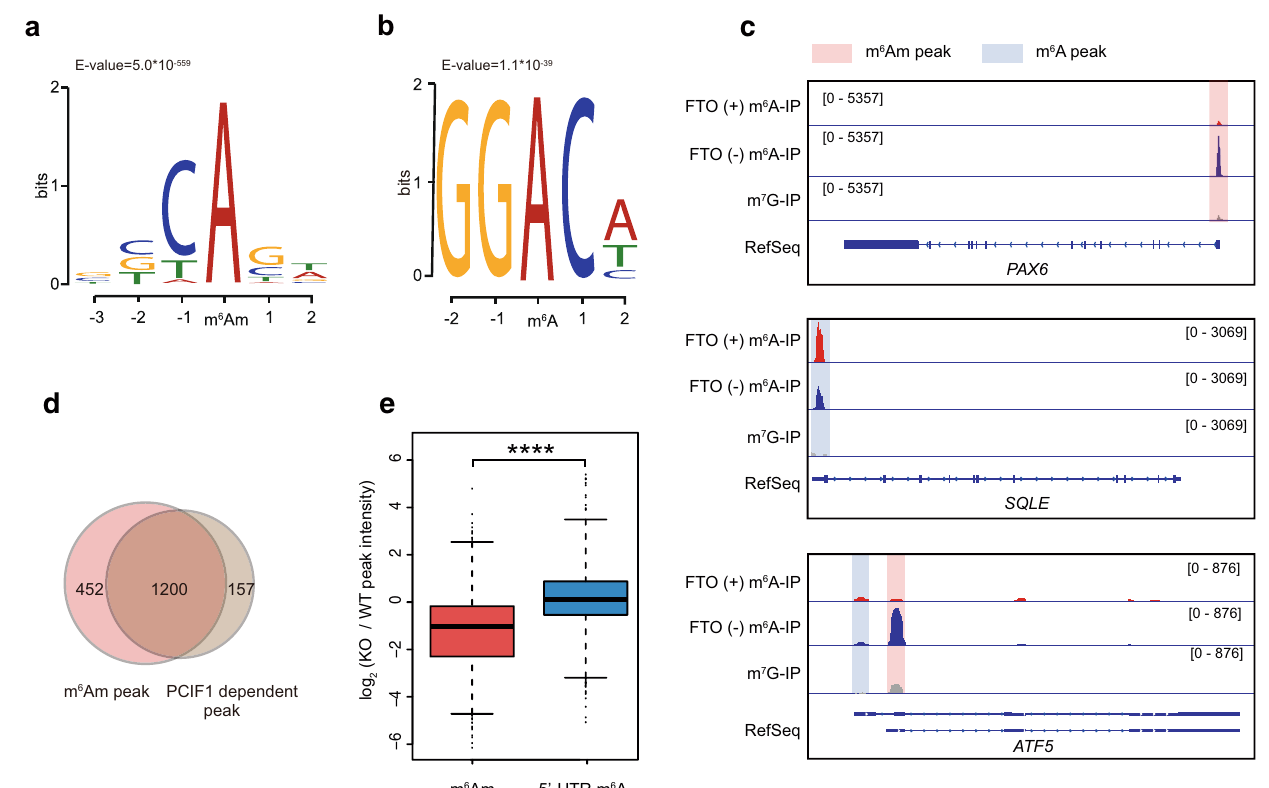
Fig. 2 m 6 Am-seq uncovers the high-con fi dence m 6 Am and 5 ′ -UTR m 6 A methylation in the human transcriptome. Motif analysis of m 6 Am peaks ( a ) and 5 ′ -UTR m 6 A peaks ( b ) identi fi ed by m 6 Am-seq. c Representative views of typical m 6 Am peaks and 5 ′ -UTR m 6 A peaks on mRNA. The methylation peak in the 5 ′ -UTR of PAX6 was lost in “ FTO ( + ) m 6 A-IP ” samples, suggesting a demethylase-sensitive m 6 Am modi fi cation (top); the methylation peak in the 5 ′ - UTR of SQLE retained well in “ FTO ( + ) m 6 A-IP ” samples, suggesting a demethylase-insensitive m 6 A modi fi cation (middle); while multiple isoforms of ATF5 were differentially marked by m 6 Am and 5 ′ -UTR m 6 A (bottom). Pink and blue background colors denote m 6 Am and m 6 A signals, respectively. d Venn diagram showing the overlap between m 6 Am peaks identi fi ed directly by m 6 Am-seq and m 6 Am peaks identi fi ed indirectly by m 6 A IP using PCIF1-KO samples. e Boxplot showing that the peak intensity of m 6 Am (red, n = 1652), but not that of m 6 A (blue, n = 1307), was signi fi cantly reduced upon PCIF1 depletion. Statistical signi fi cance of the difference was determined by unpaired two-sided Mann – Whitney U -test. **** P < 2.2e − 16 . Boxes represent 25th – 75th percentile (line at median) with whiskers at 1.5*IQR. Source data are provided as a Source Data fi